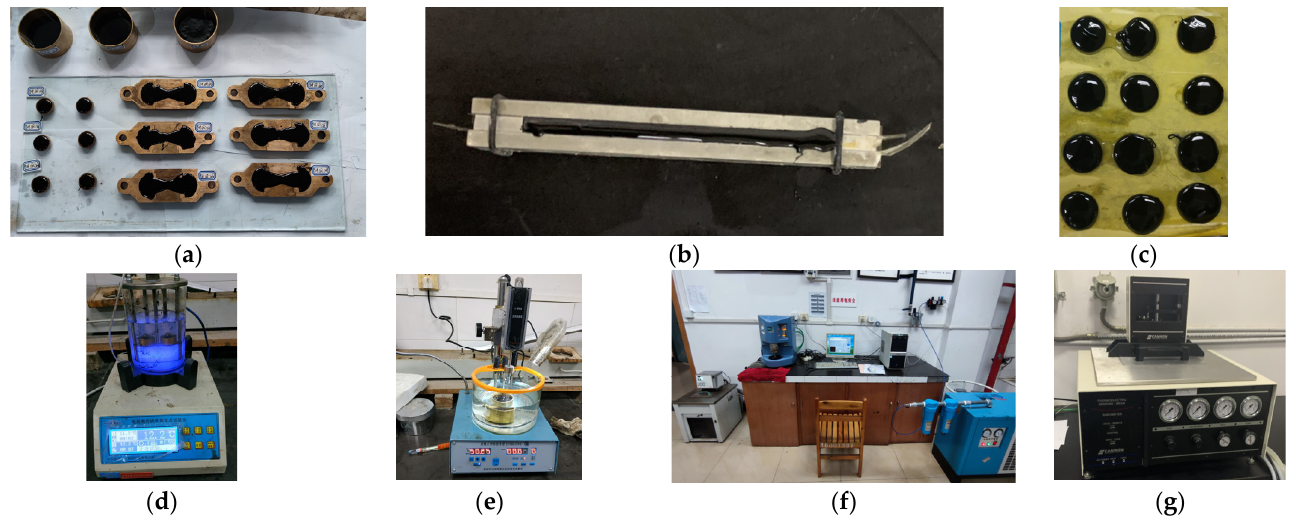
Figure 4. Performance test of emulsified asphalt residue: ( a ) specimens of conventional performance test; ( b ) specimens of bending beam rheological test (BBR); ( c ) specimens of dynamic shear rheometer (DSR) test; ( d ) softening point test; ( e ) penetration degree test; ( f ) dynamic shear rheometer (DSR) test; ( g ) bending beam rheological test (BBR).